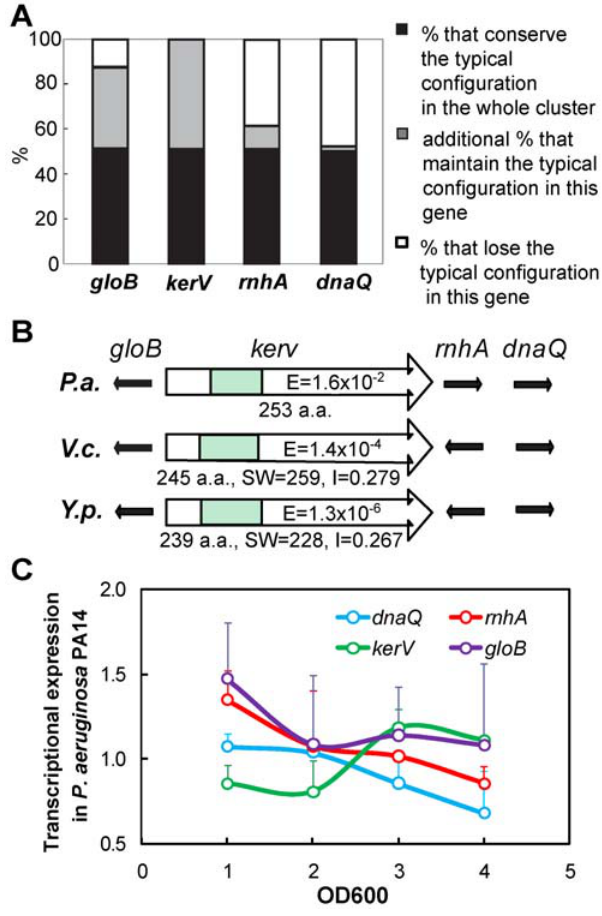
Figure 3. KerV orthologs are located in a conserved genomic neighborhood with typical configuration in many species. (A) Conservation of the typical configuration. Data are based on the 197 bacterial strains that have a KerV ortholog with SW-score . 100. (B) The typical configuration in P. aeruginosa ( P.a. ), V. cholerae ( V.c. ) and Y. pseudotuberculosis ( Y.p. ). Green boxes represent the methyltransferase type_11 motif (Pfam08241) and are shown to scale with respective KerV orthologs. E, expectation value for homology with Pfam08241. SW, SW- score of ortholog if searched using PA14 KerV; I, identity of the ortholog. Arrows indicate the predicted transcriptional direction of each gene. (C) Transcriptional expression of kerV in PA14 is distinctive from that of gloB , rnhA and dnaQ . Error bars show standard deviations in one experiment. The illustrated trends are representative of multiple experiments.